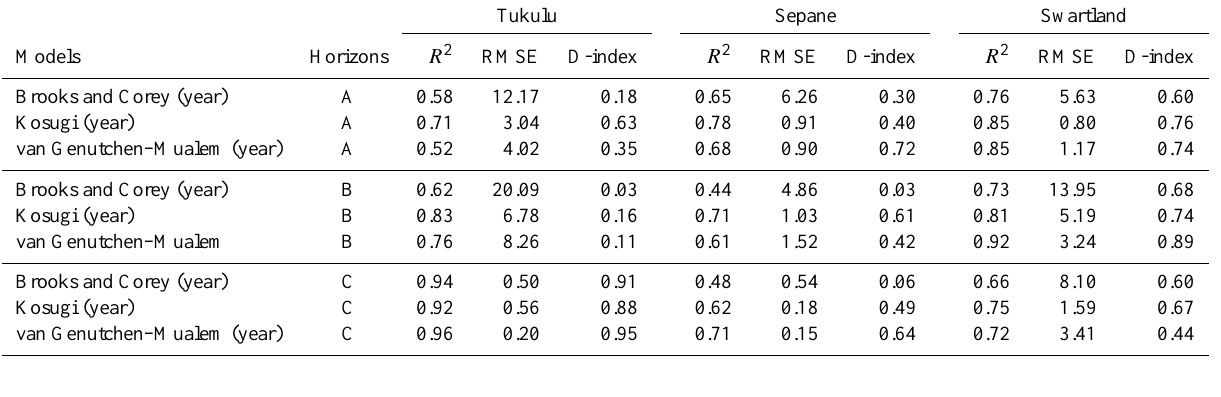
Table 3. Statistical measure of fit for conductivity-based parametric models on in situ K coefficient for the Tukulu, Sepane and Swartland soil horizons.